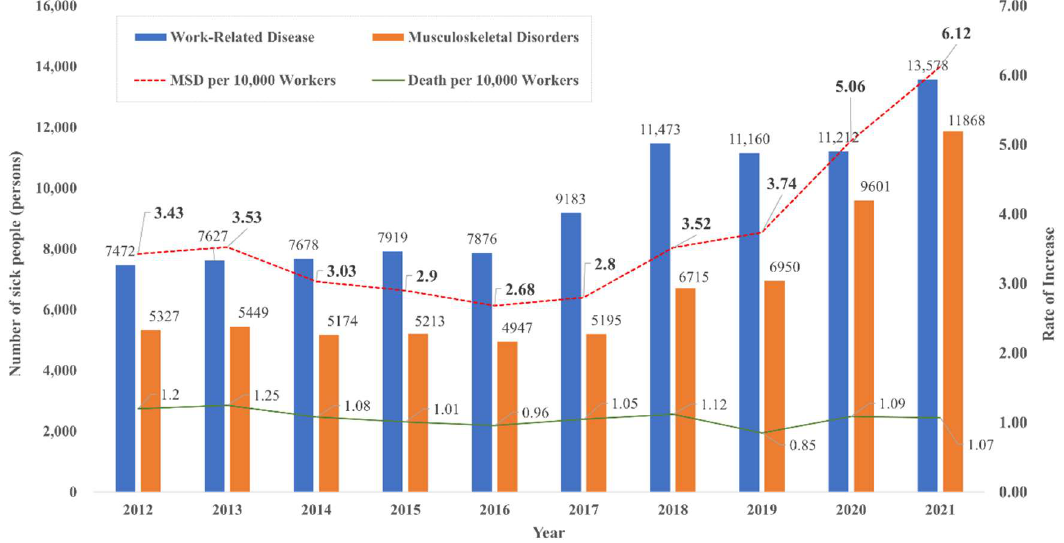
Figure 1. Occupational accidents in Korea in 2012–2021.